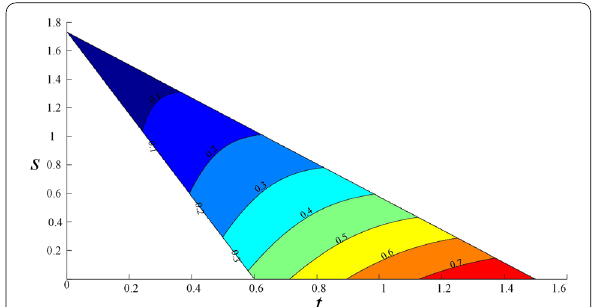
Figure 4 Distribution of output transmission index